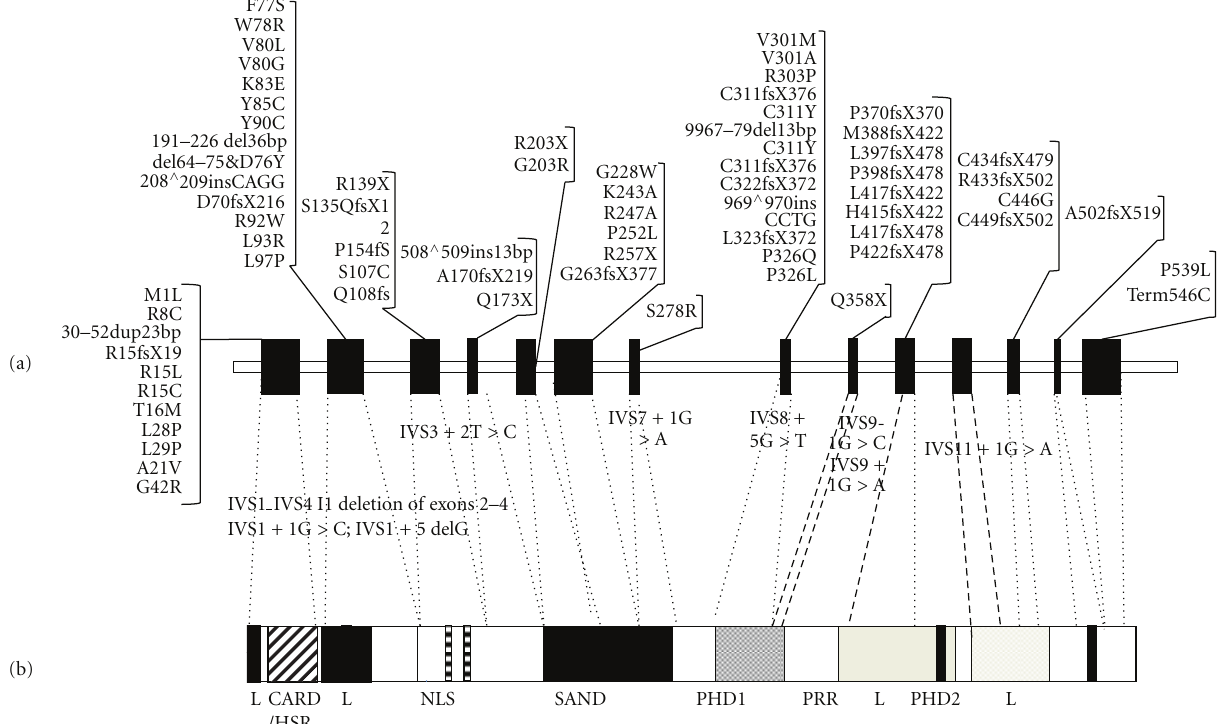
Figure 1: AIRE gene mutations (a) and functional domains of corresponding protein (b). Modified by Meloni et al [68].